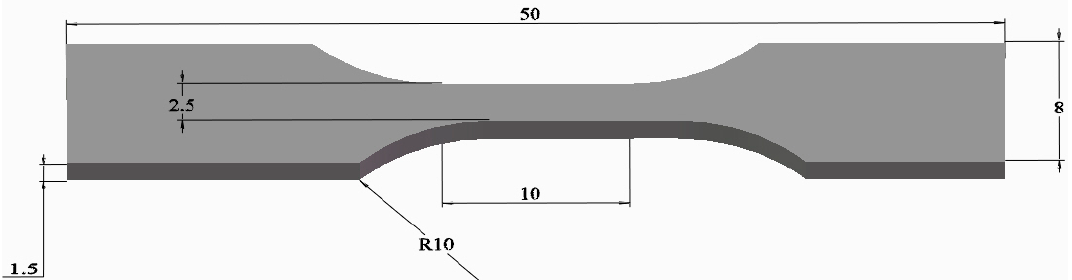
Figure 3. Dimensions of the tensile testing specimen (unit: mm).